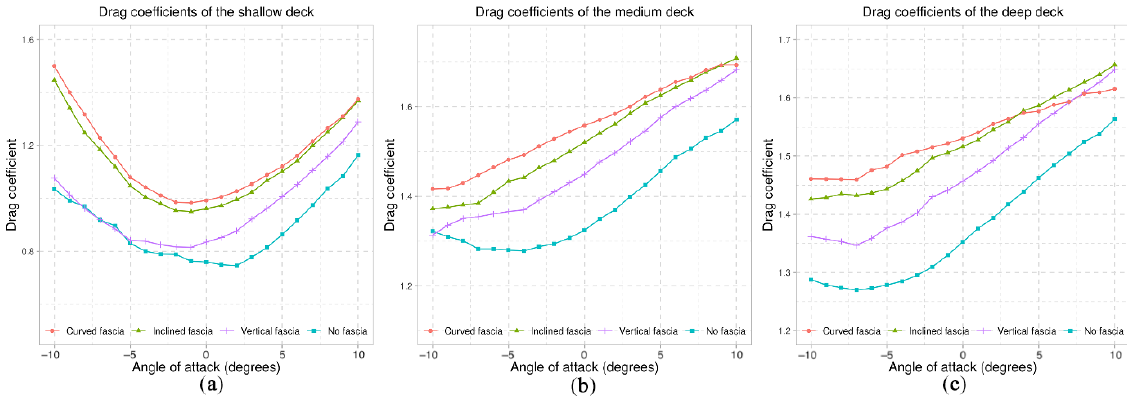
Figure 23. Fascia beams considered in the design: ( a ) Vertical fascia beam; ( b ) Inclined fascia beam; ( c ) Curved fascia beam; ( d ) Locations of fascia beams on the deck.